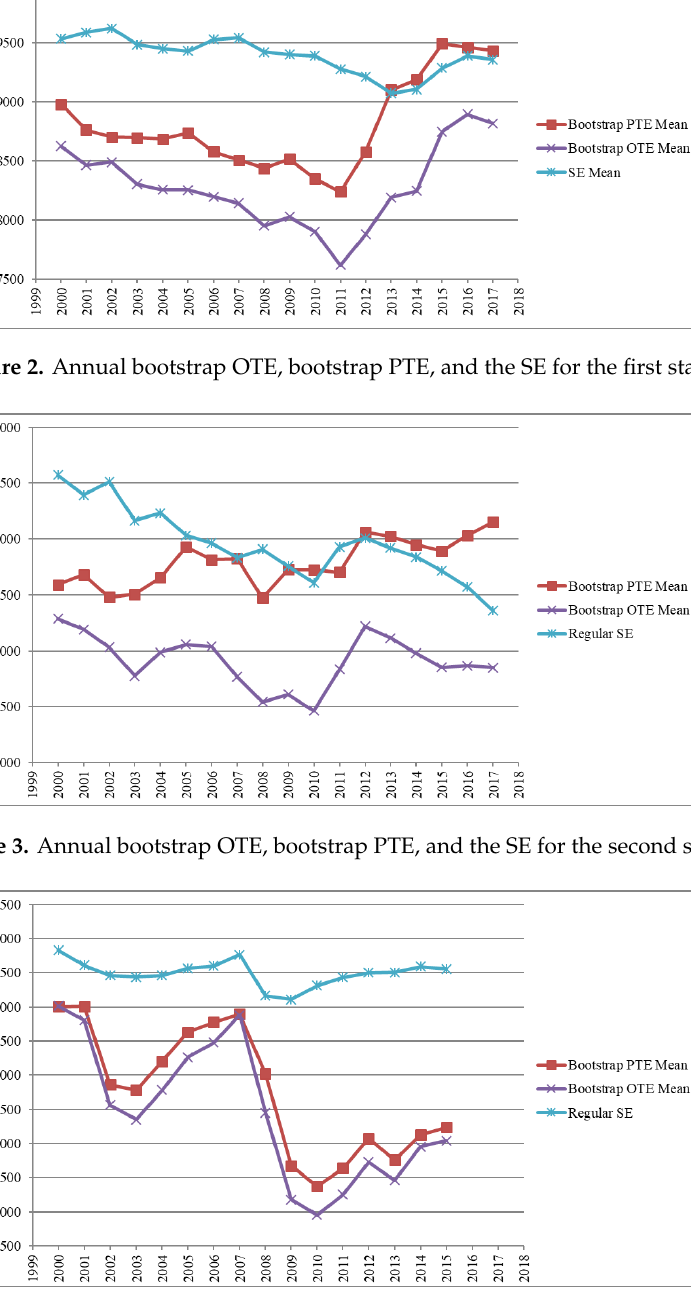
Figure 4. Annual bootstrap OTE, bootstrap PTE, and the SE for the third stage.